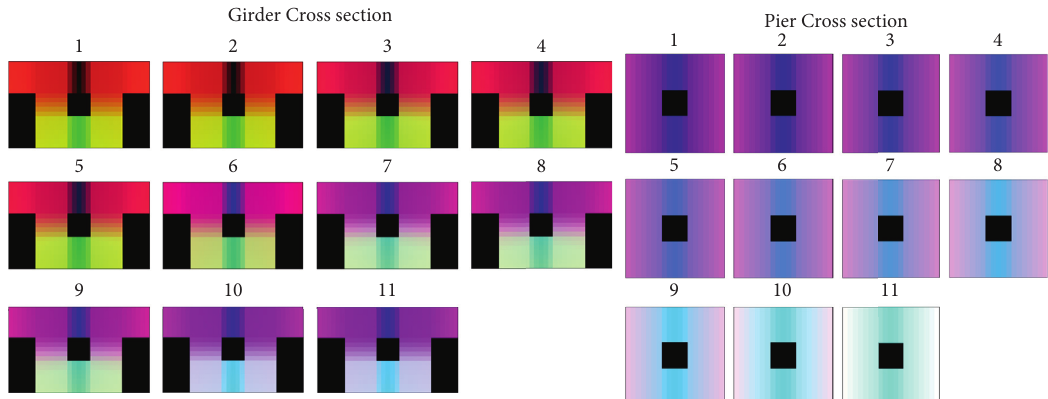
Figure 3: Schematic diagram of the 3D representation